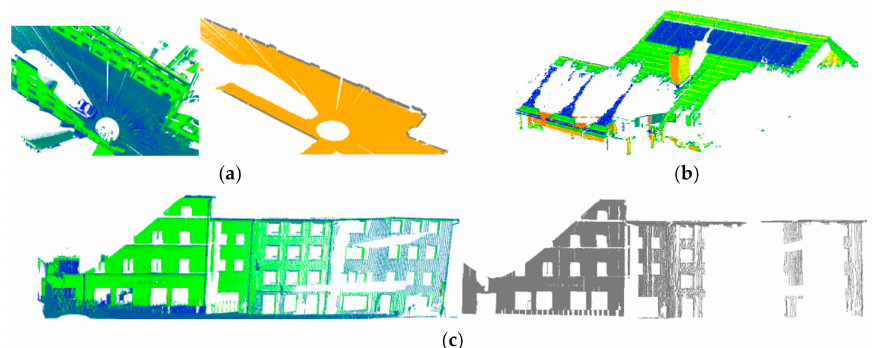
Figure 20. Different types of FN errors (missing detection). For each sub-figure, the left side shows the original points rendered by intensity. The right side in ( a ) shows the ground filtering result of a selected area (left). Real ground points are colored orange and building points recognized as ground points are colored gray. ( b ) shows a building with few facade points. In ( c ), the right side shows the extraction results (gray) of the original point cloud on the